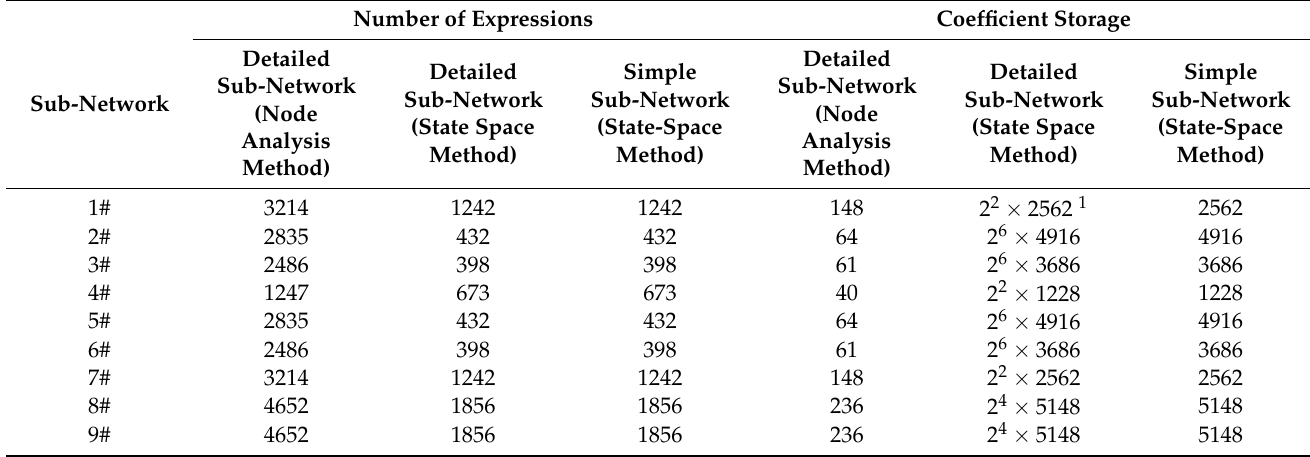
Table 4. The number of expressions and coefficient storage of each sub-networks.